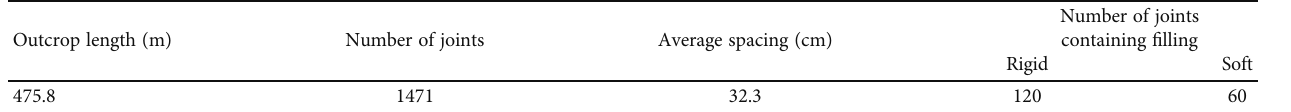
Figure 1: Geographicallocation of the study area andsite work. (a), (b), and (c) are manual investigation with geological compassand tape Table 1: Distribution of joints in the study area.